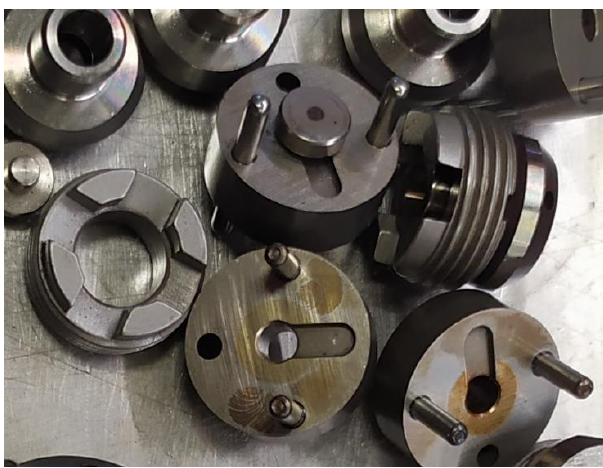
Fig. 7. Disassembled nozzle plunger guides and valve assemblies